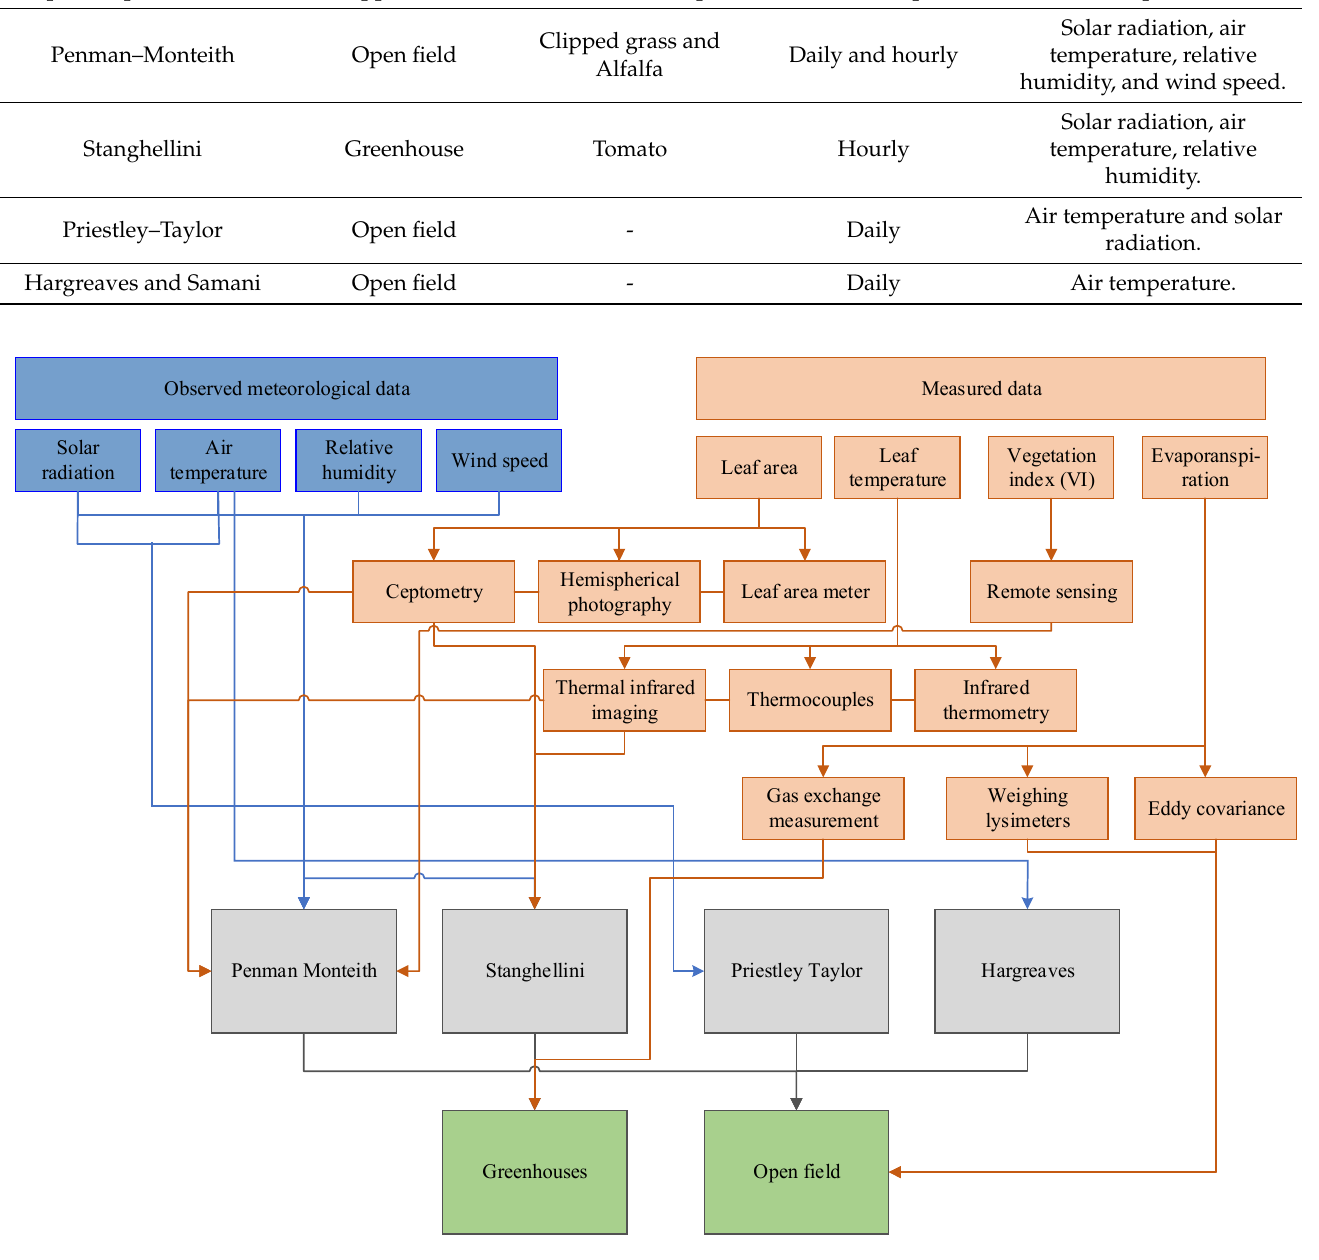
Figure 3. Directions for evapotranspiration measurements.